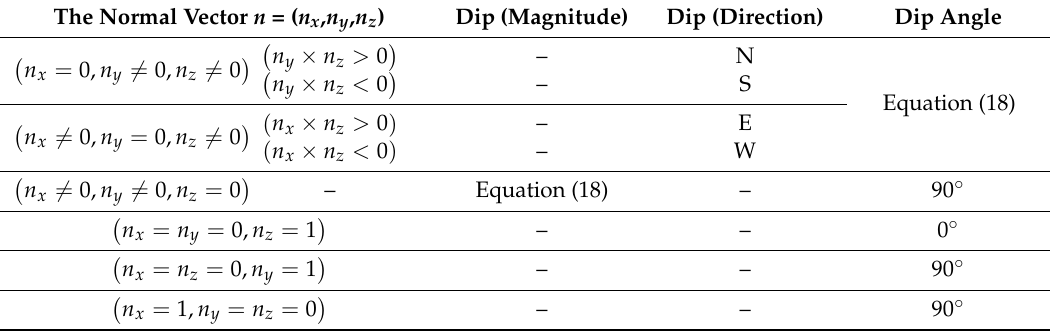
Table 2. The relation of the normal vector and the dip for horizontally and vertically developed rock